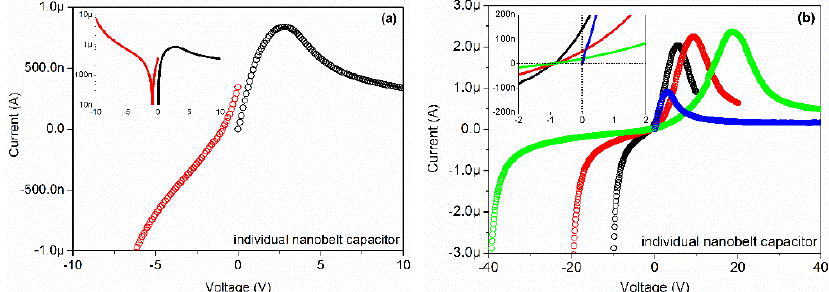
Figure 2. Current-voltage (I-V) characteristics of the individual Ga 2 O 3 nanobelt on Pt interdigital electrodes (IDEs).